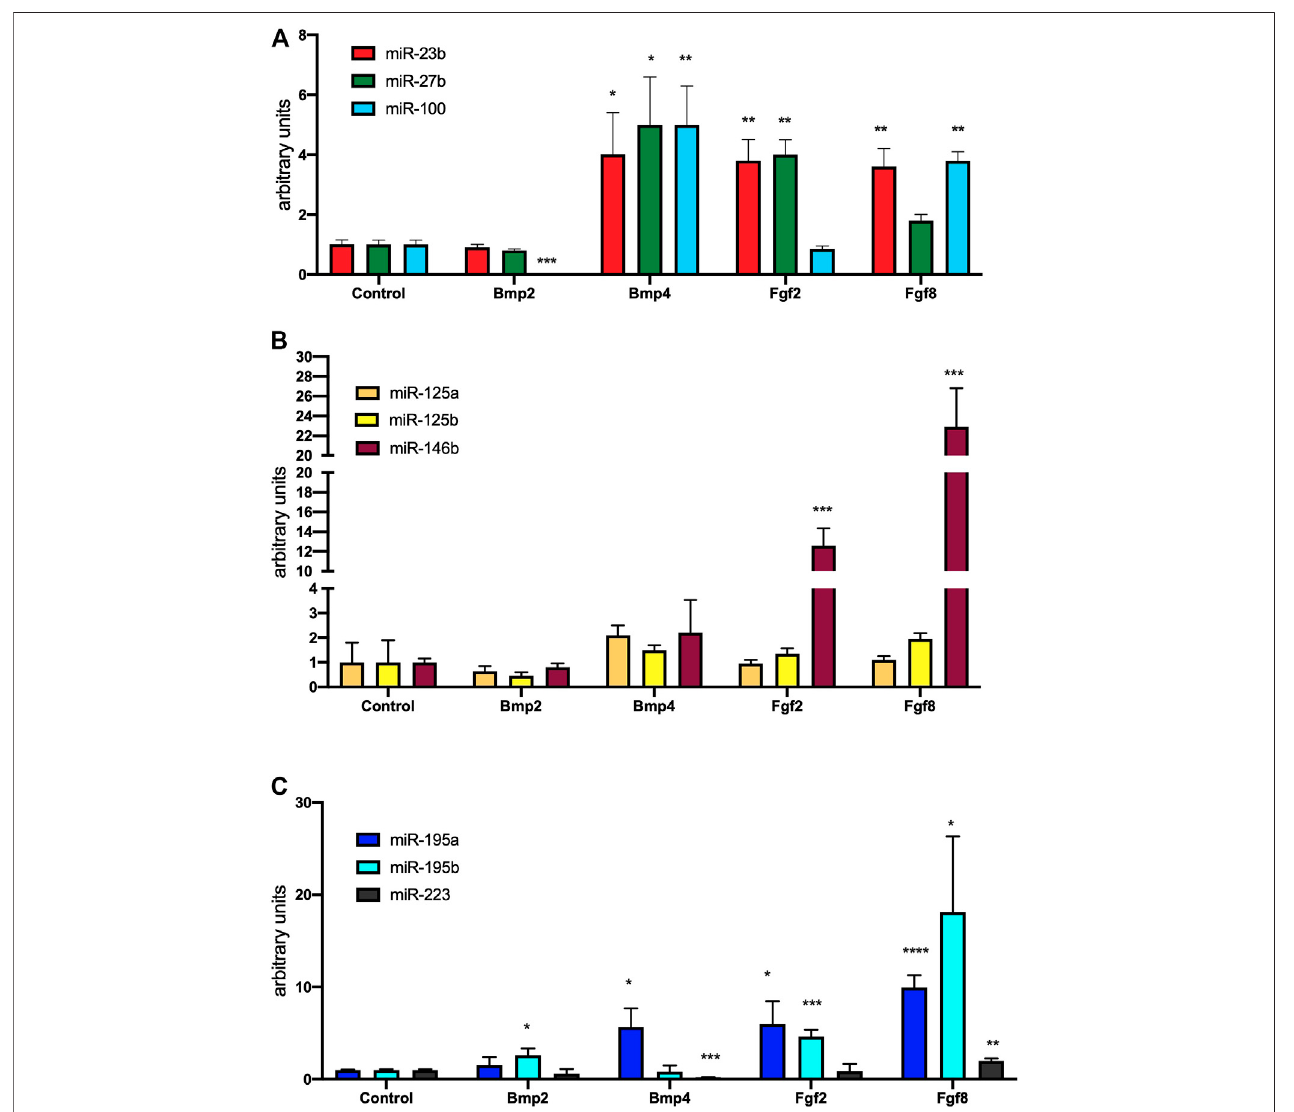
FIGURE 2 | Panel (A) RT-qPCR analyses of miR-23b, miR-27b and miR-100 expression after control, Bmp2, Bmp4, Fgf2 and Fgf8 treatments, respectively, to mouse E9.5 PE/ST explants. Panel (B) RT-qPCR analyses of miR-125a, miR-125b and miR-146b expression after control, Bmp2, Bmp4, Fgf2 and Fgf8 treatments, respectively, to mouse E9.5 PE/ST explants. Panel (C) RT-qPCR analyses of miR-195a, miR-195b and miR-223 expression after control, Bmp2, Bmp4, Fgf2 and Fgf8 treatments, respectively, to mouse E9.5 PE/ST explants. * p < 0.05, ** p < 0.01, *** p < 0.001, **** p < 0.0001.